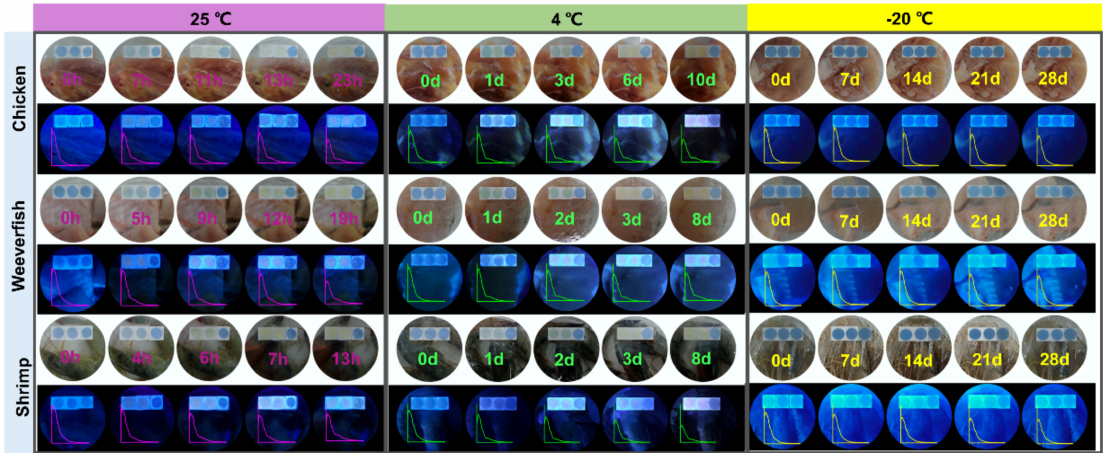
Figure 3. Real-time and visual monitoring of BAs produced from chicken, weeverfish, and shrimp at different storage temperatures of 25 ◦ C, 4 ◦ C, and − 20 ◦ C. The first two paper chips in each dish indicate the experimental group and the last paper chip indicates the control